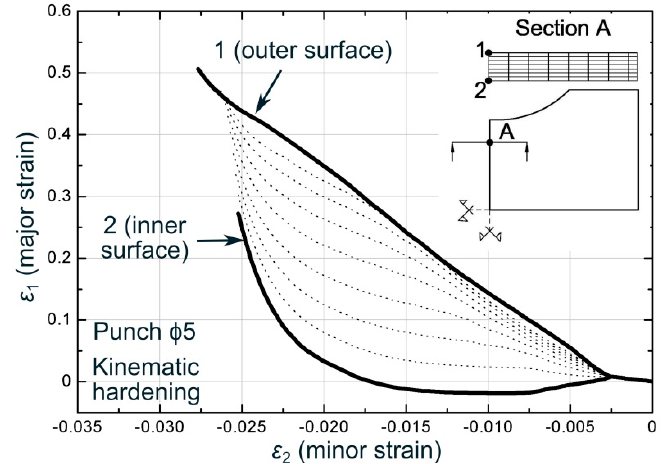
Figure 11. Strain path evolutions at the outer, intermediates, and inner surfaces for φ 5 mm cylindrical punch around the failure location.